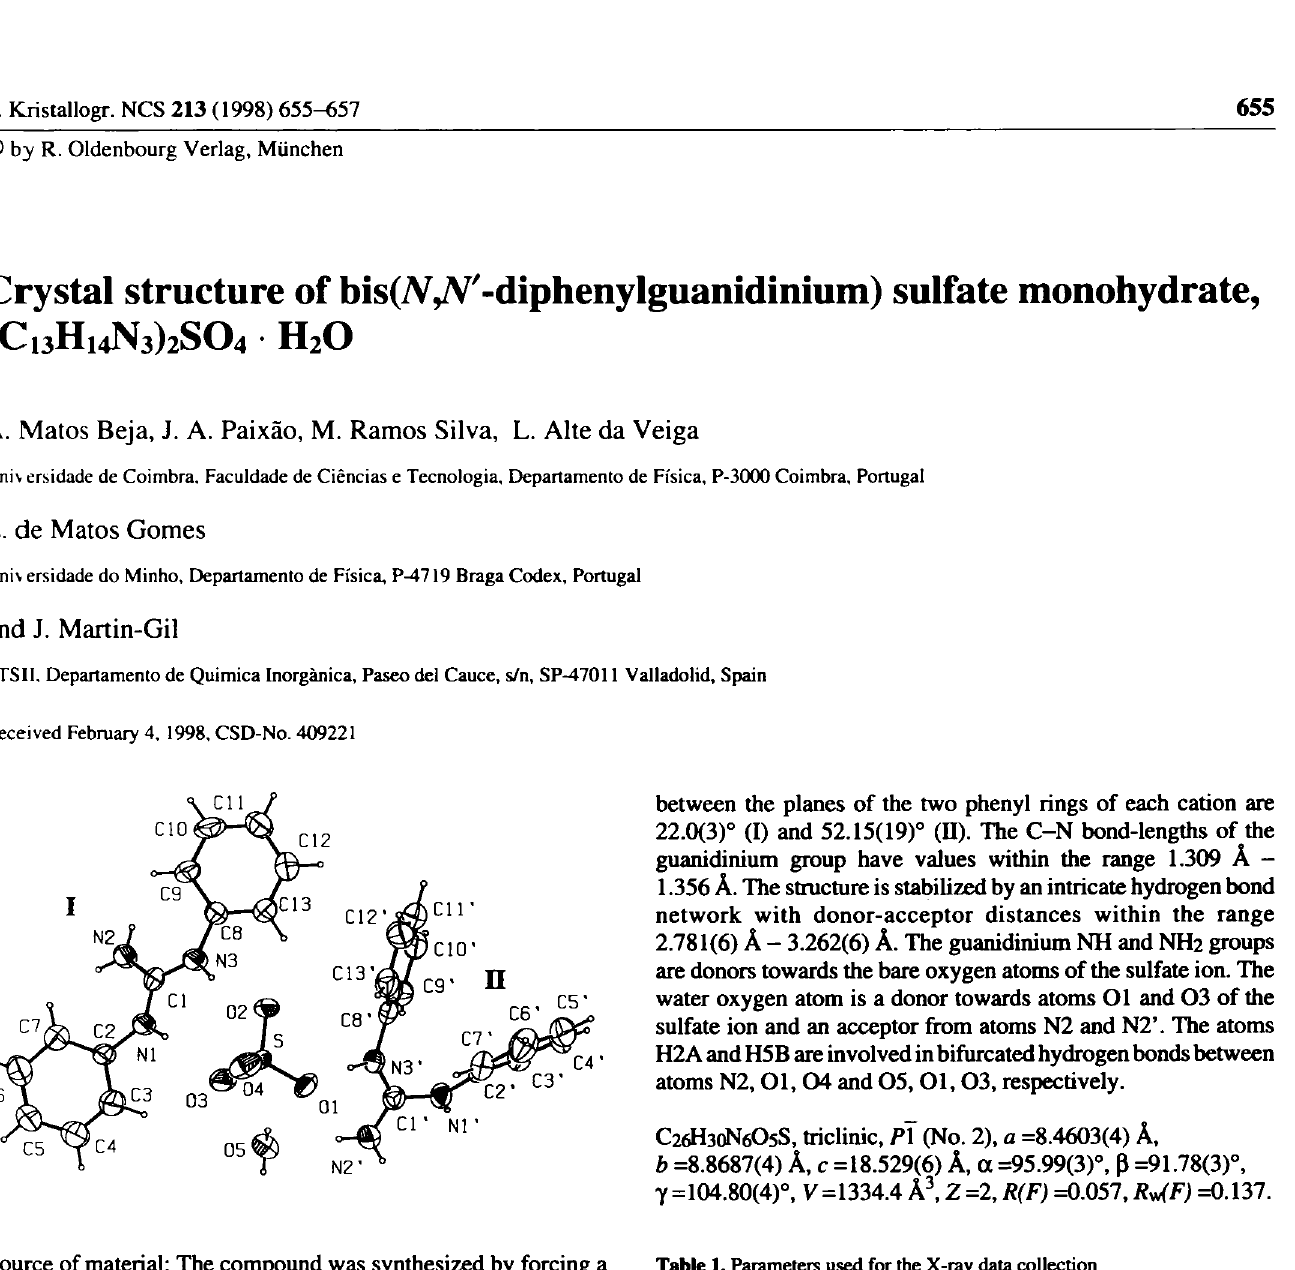
Table 1. Parameters used for the X-ray data collection